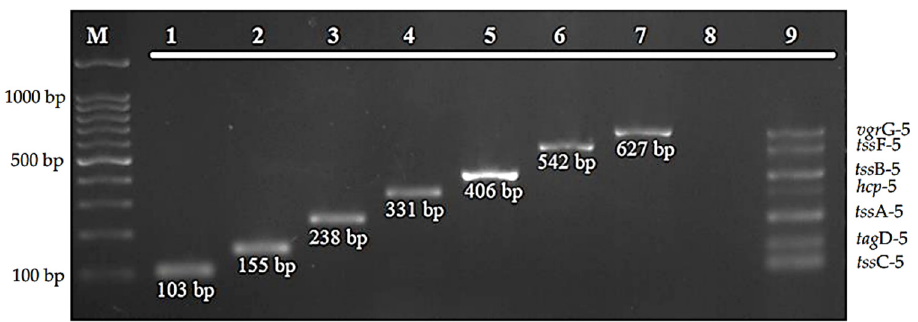
Figure 1. Amplification of the target genes by the developed multiplex PCR assay. Lane M: 100 bp DNA marker; lanes 1–7: monoplex PCR of tss C-5, tag D-5, tss A-5, hcp -5, tss B-5, tss F-5, vgr G-5, respectively; lane 8: negative control; and lane 9: multiple bands of all seven genes.